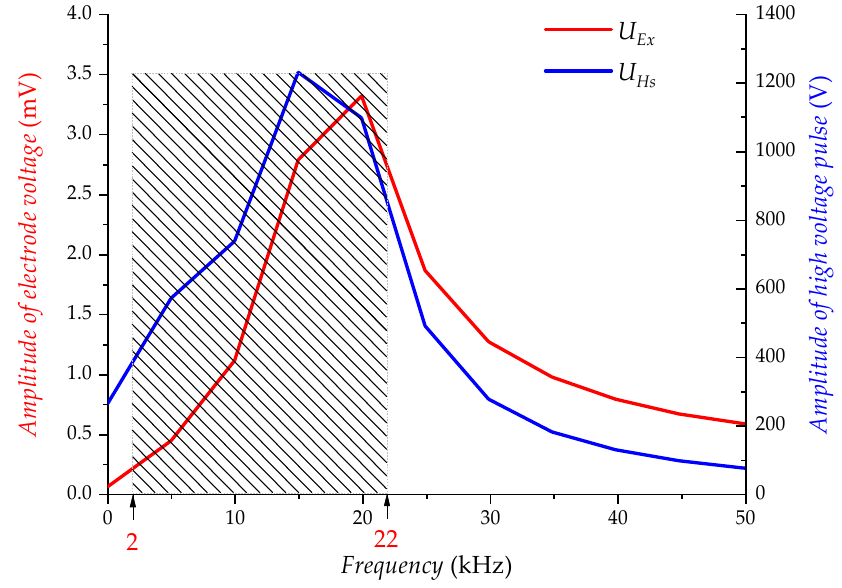
Figure 14. Frequency domain diagram of U Ex and U Hs (simulation). Therefore, the interference signal not only affects the observation of the acoustoelectric signal, but it also leads to the inability to obtain clean results by data processing. Figure 15 shows the potential distribution of the borehole and the formation at the 10 µ s moment. The detection range of the electrodes is large enough to reflect the contribution of the formation. The formation radius of 2 m is still used for the subsequent simulations, because the effect of the formation beyond 1 m on the measurement results is small according to the potential distribution.